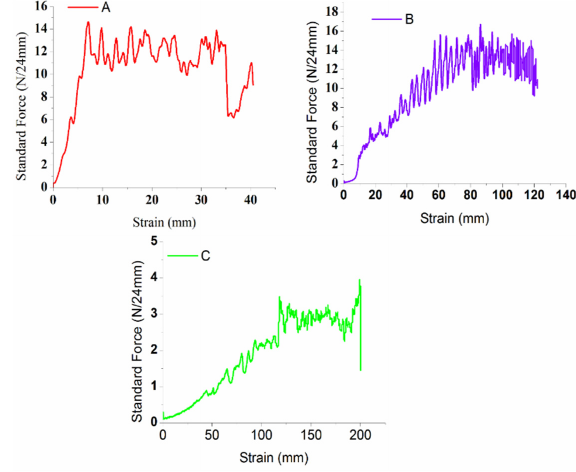
Figure 6. Peel test analysis of type I specimens A, B, and C. According to this figure, it is clear that specimen B (with 80% resin and 20% hardener) uses maximum force in debonding the laminate layers compared to other specimens with codes A and C. This force is expressed as 16.5 N/24 mm. Comparison values of the peel test shown in Figure 7.